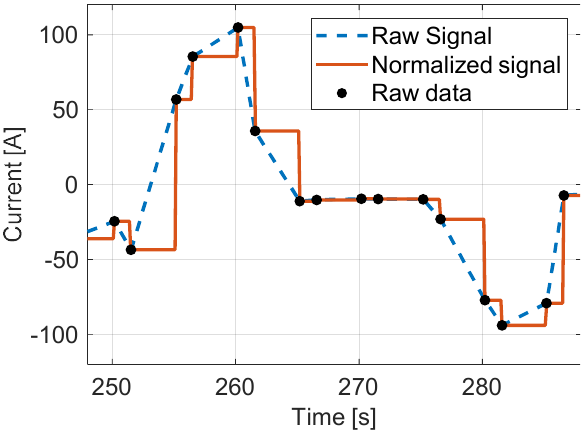
Figure 3. Raw current signal collected from the server compared with the corrected and normalized current signal.